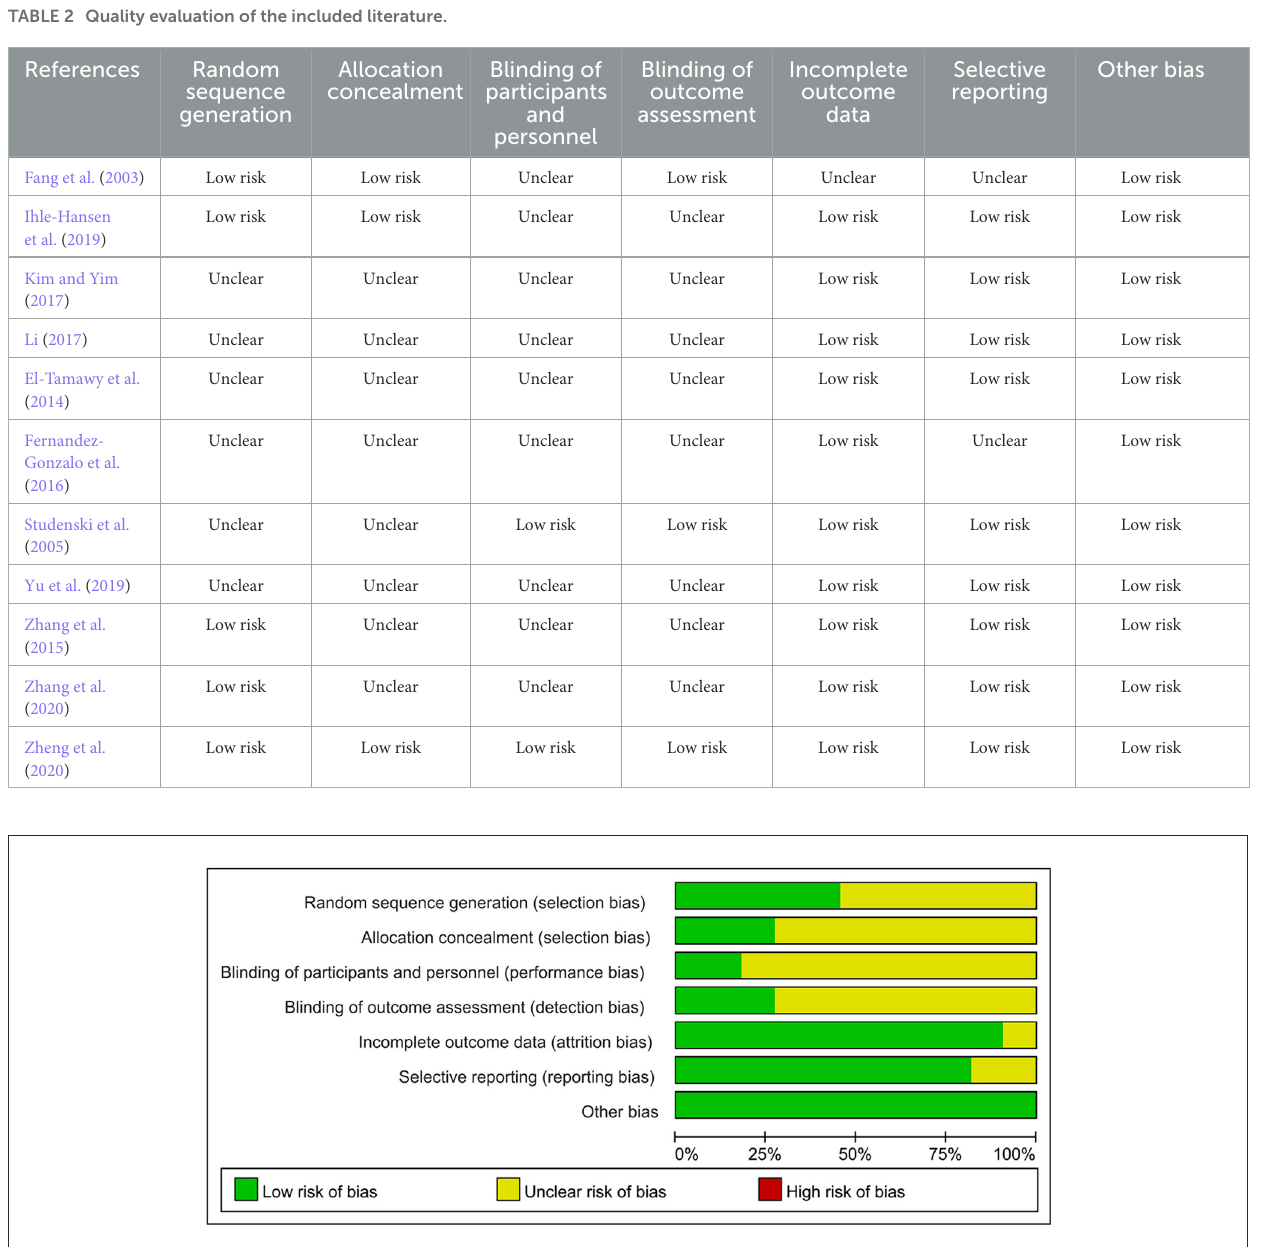
FIGURE2 Risk assessment of